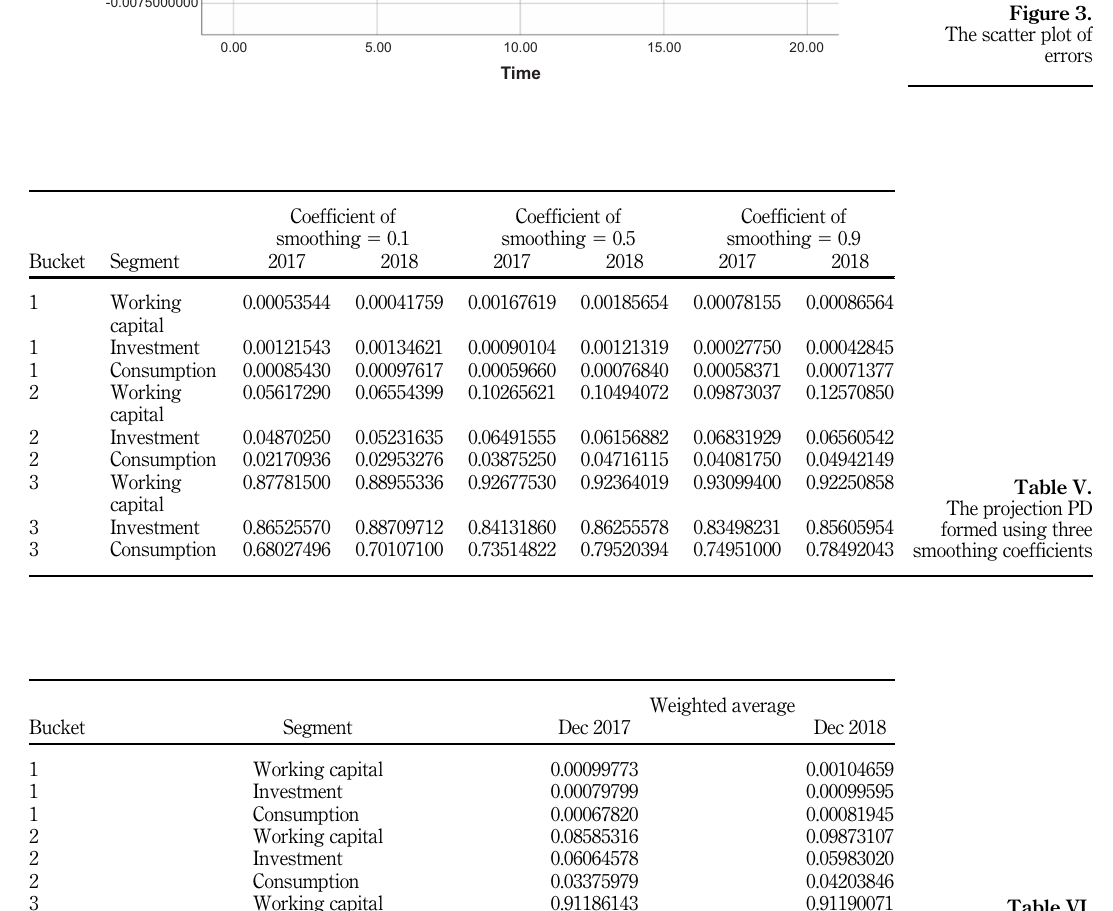
Figure 3. The scatter plot of